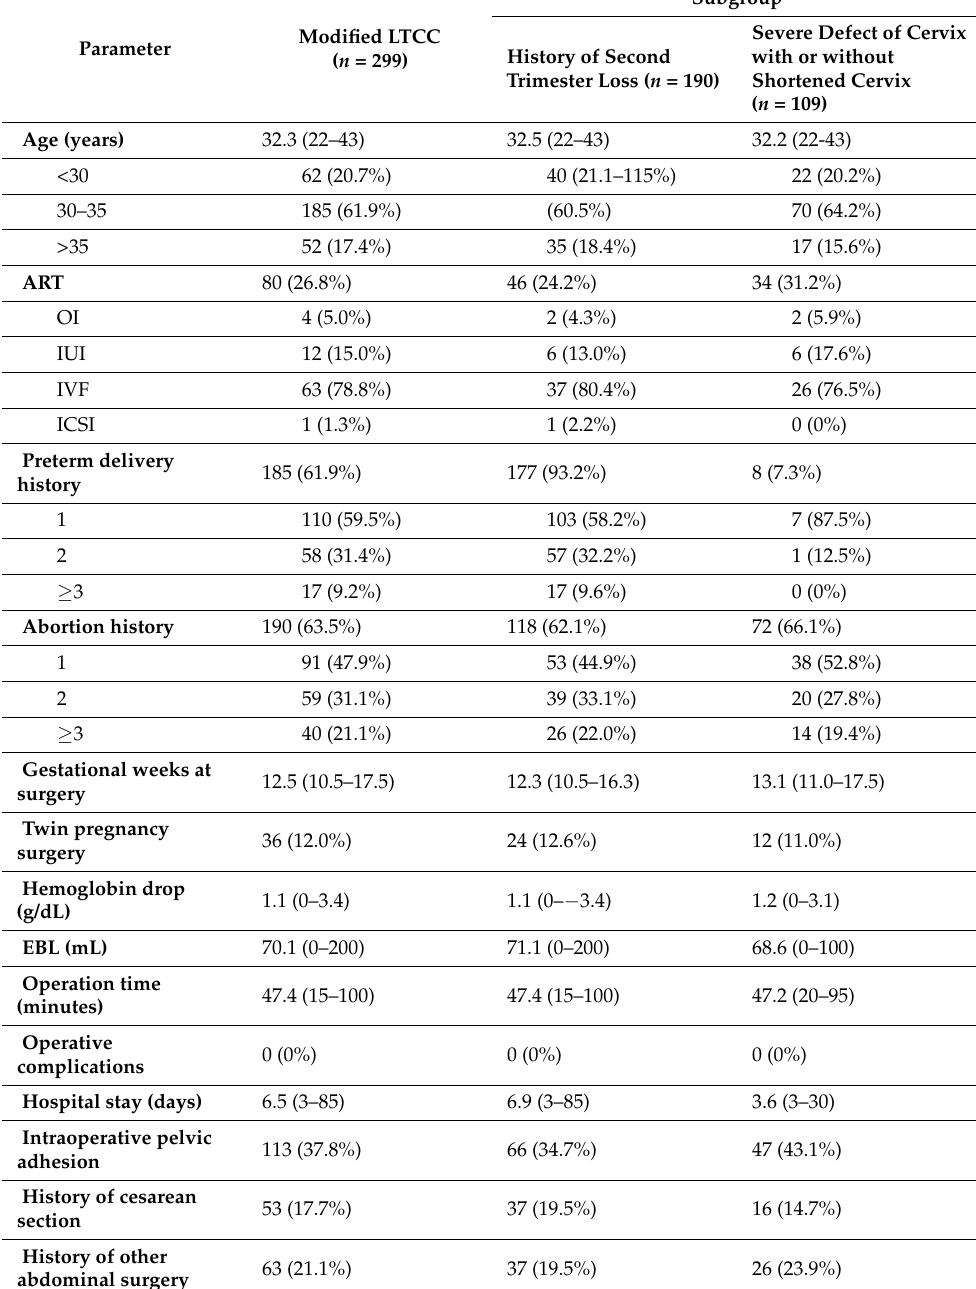
Table 2. Basic characteristics and surgical outcomes of modified